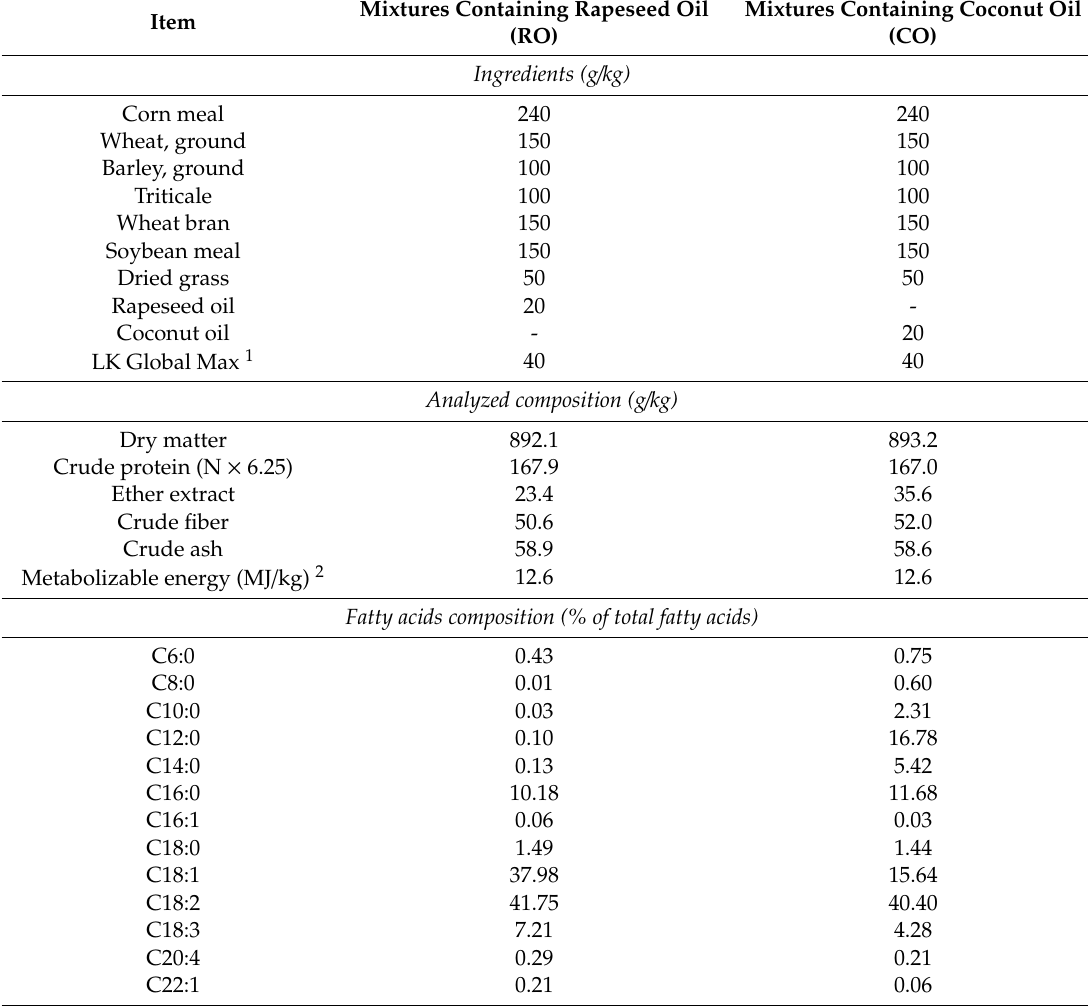
Table 1. Chemical composition and fatty acid composition of basal feeds supplemented with di ff erent oils, served for sows during late pregnancy and